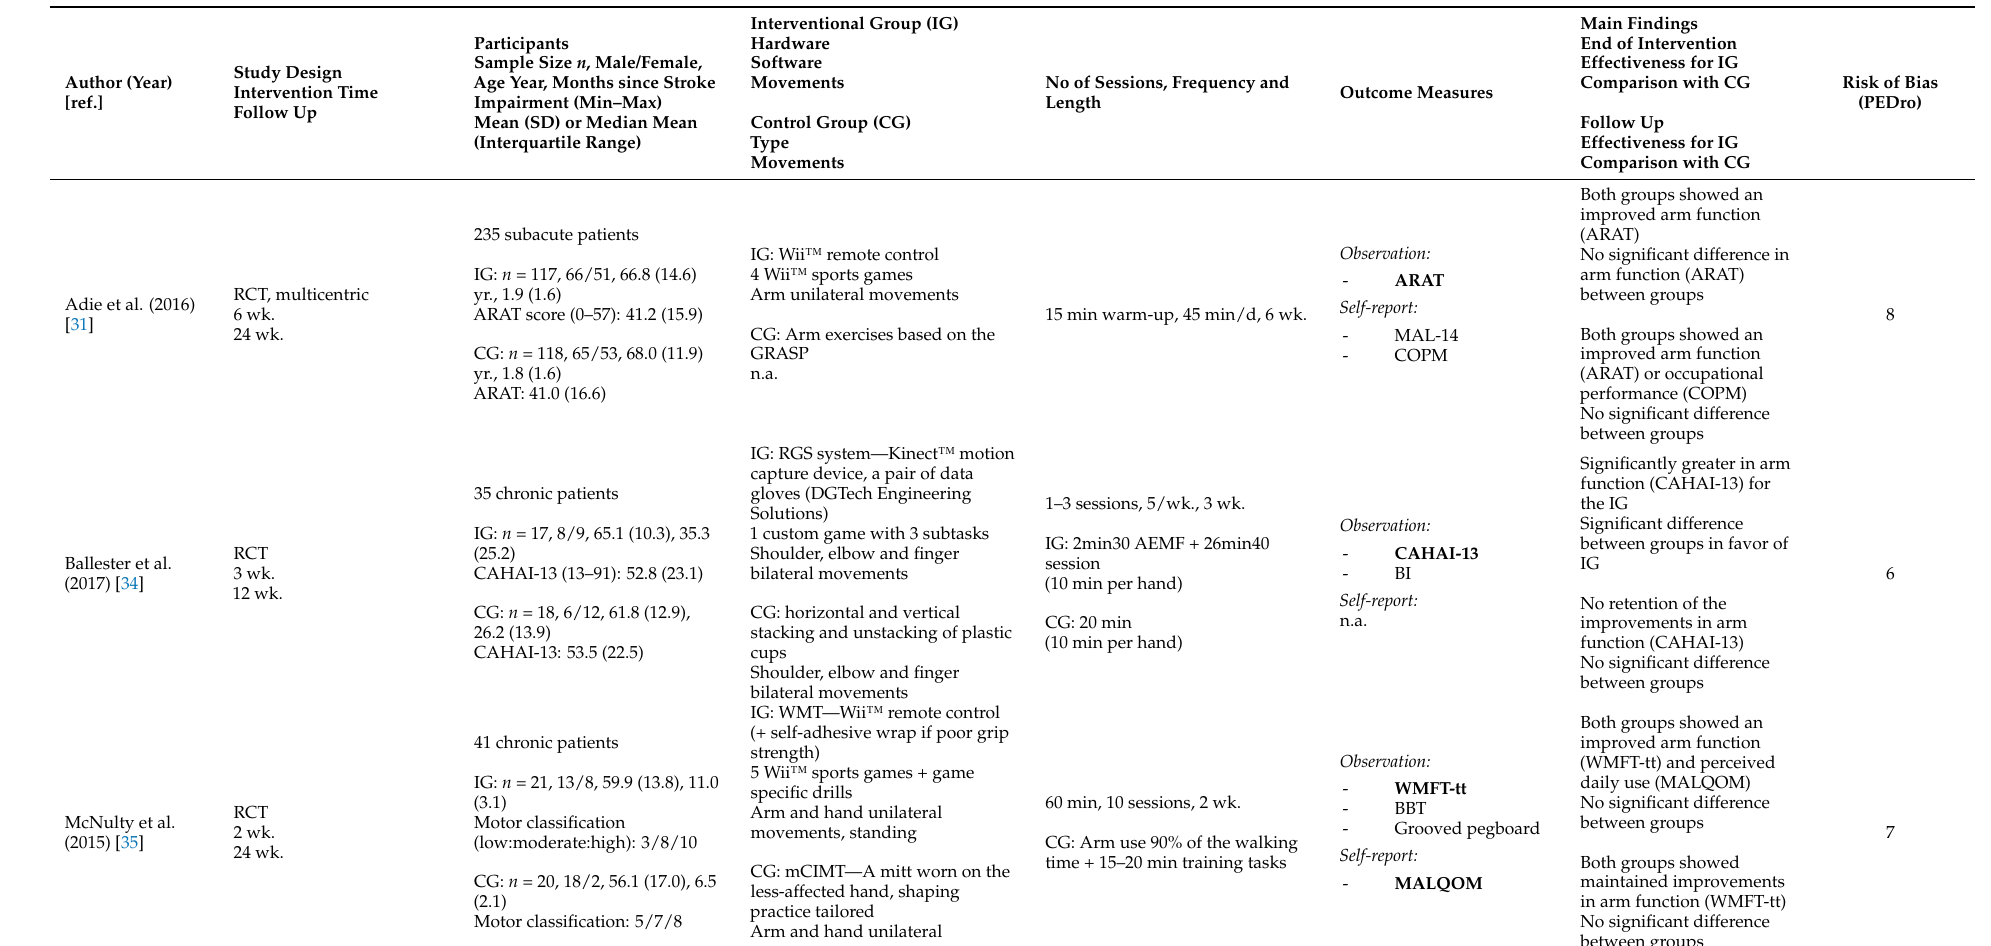
Table 1. Characteristics of the included RCT studies ( n = 9) (main outcome in